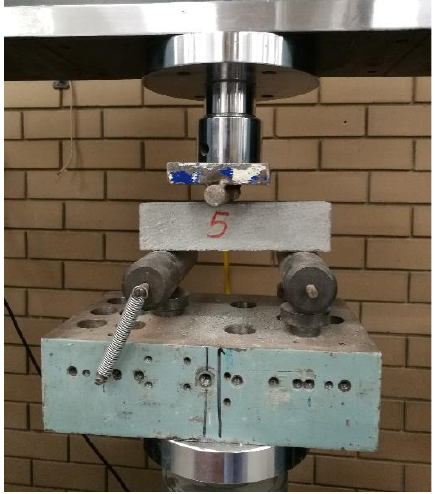
Figure 3. Three-point flexural test setup.